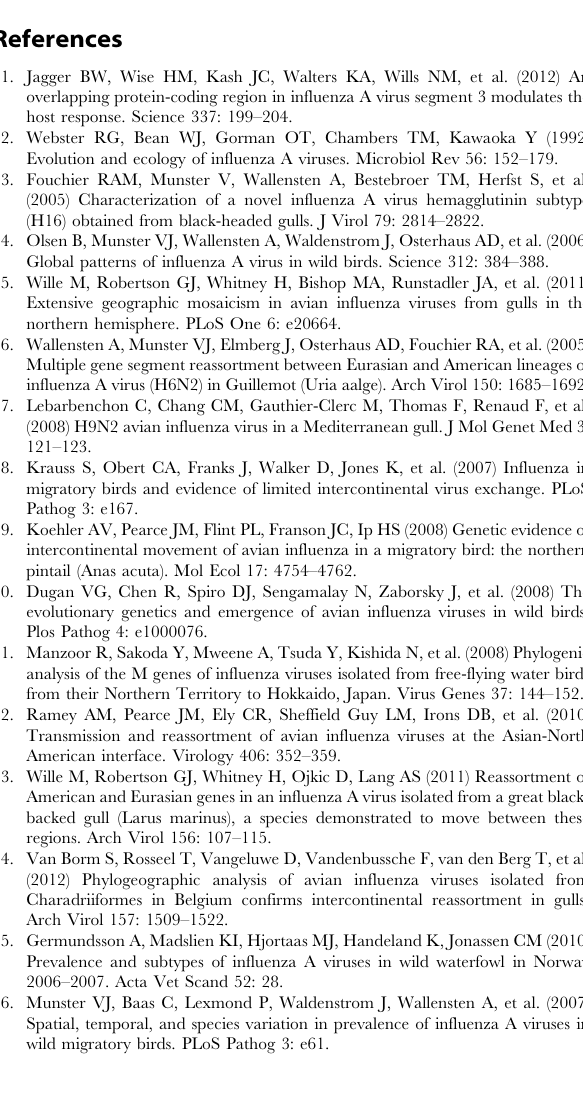
Figure S5 Amino acid heterogeneity in the NP protein. Amino acid heterogeneity in the NP protein of the 15 Eurasian avian (non H13 and H16) and Eurasian gull (H13 and H16) avian influenza viruses (AIVs) included in the initial analysis. (TIF) Figure S6 Amino acid heterogeneity in the M1 protein. Amino acid heterogeneity in the M1 protein of the 15 Eurasian avian (non H13 and H16) and Eurasian gull (H13 and H16) avian influenza viruses (AIVs) included in the initial analysis. (TIF) Figure S7 Amino acid heterogeneity in the M2 protein. Amino acid heterogeneity in the M2 protein of the 15 Eurasian avian (non H13 and H16) and Eurasian gull (H13 and H16) avian influenza viruses (AIVs) included in the initial analysis. (TIF) Figure S8 Amino acid heterogeneity in the NS1 protein. Amino acid heterogeneity in the NS1 protein of the 15 Eurasian avian (non H13 and H16) and Eurasian gull (H13 and H16) avian influenza viruses (AIVs) included in the initial analysis. (TIF) Figure S9 Amino acid heterogeneity in the NEP protein. Amino acid heterogeneity in the NEP protein of the 15 Eurasian